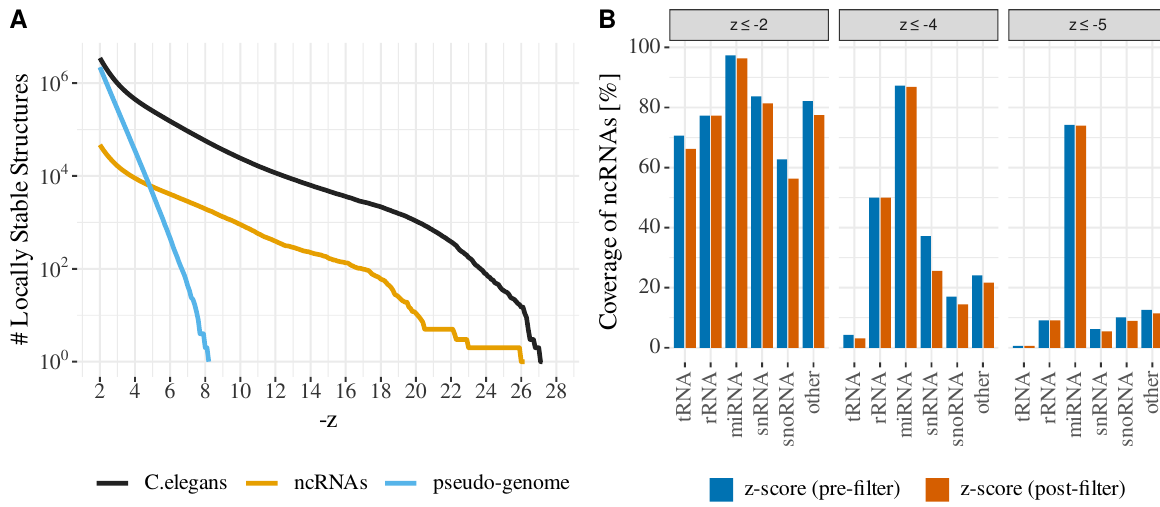
Figure 2. Predictions on the C. elegans genome. ( A ) Cumulative z -score distribution of predicted blocks with pre-filtering and default z -score threshold of z ≤ − 2.0 and window length L = 150. Shown are all predicted blocks for the entire C.elegans genome (black line) and those that sufficiently overlap with annotated ncRNAs (yellow line). The pseudo-genome (lightblue line) denotes blocks that were predicted on a di-nucleotide shuffled C. elegans genome. ( B ) Comparison of prediction coverage ( L = 150) of the two z -score filter methods. Shown is the percentage of annotated ncRNAs that are sufficiently overlapped by the predicted locally stable structures at different z -score filter